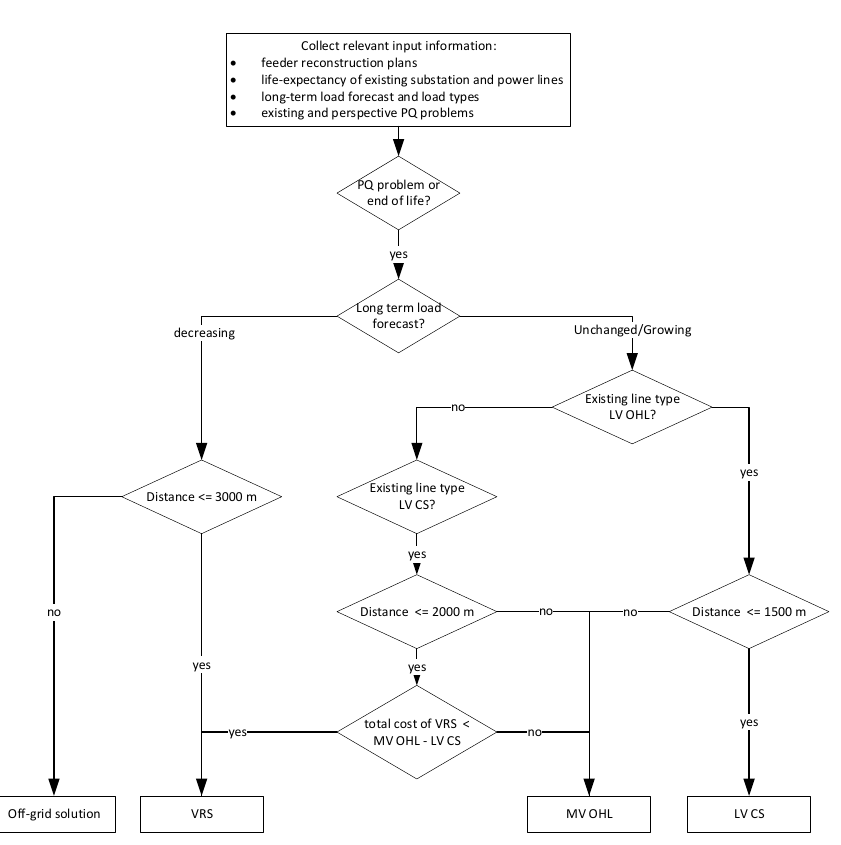
Figure A1. Method for determining the solution at the end of line lifetime or to solve voltage problems.